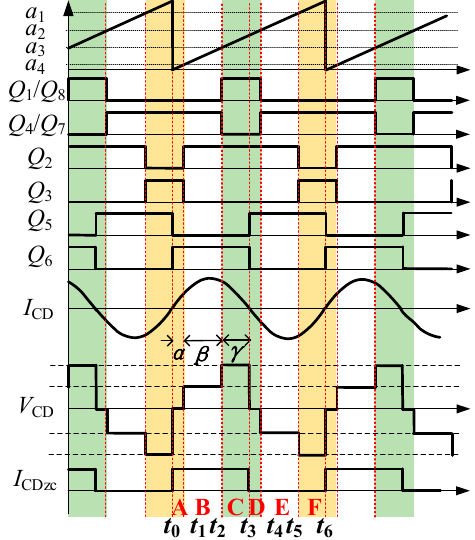
Figure 4. Key waveforms of the TL rectifier.